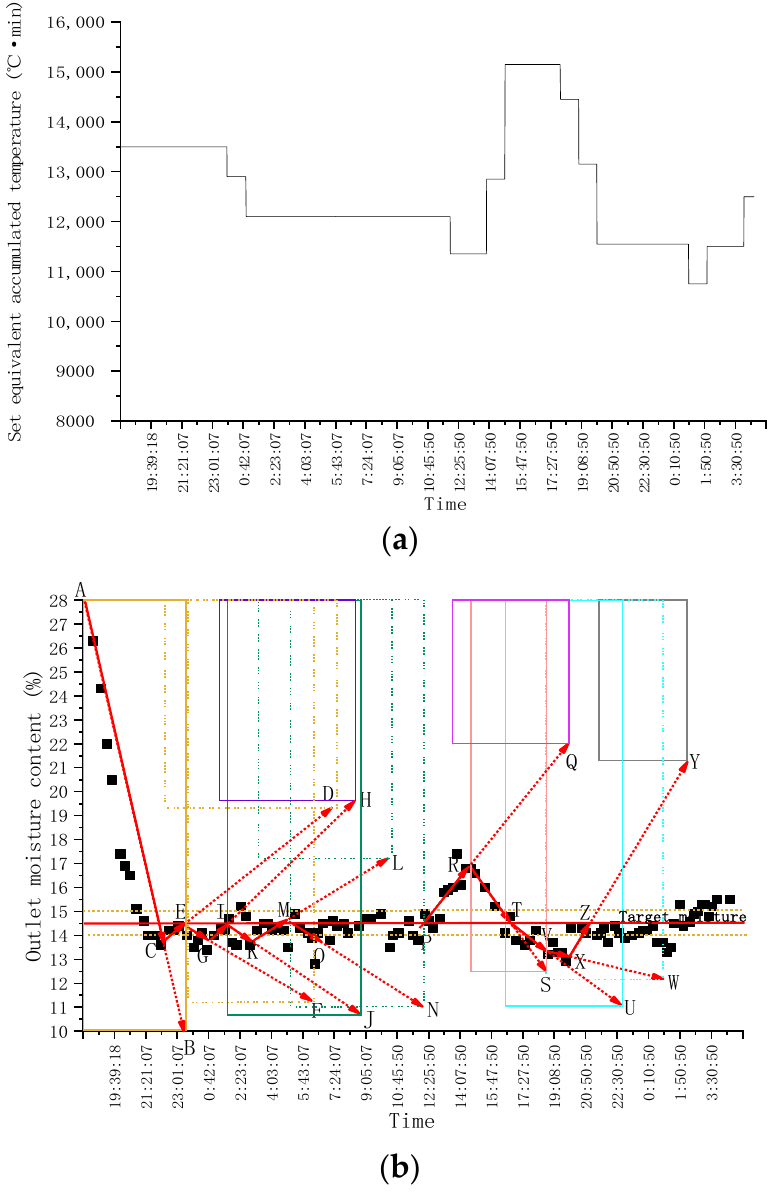
Figure 9. Variation of equivalent accumulated temperature setting value and outlet moisture with time in drying process with step change of hot air temperature: ( a ) Change process of equivalent accumulated temperature (accumulated temperature window area); ( b ) Change process of outlet moisture.